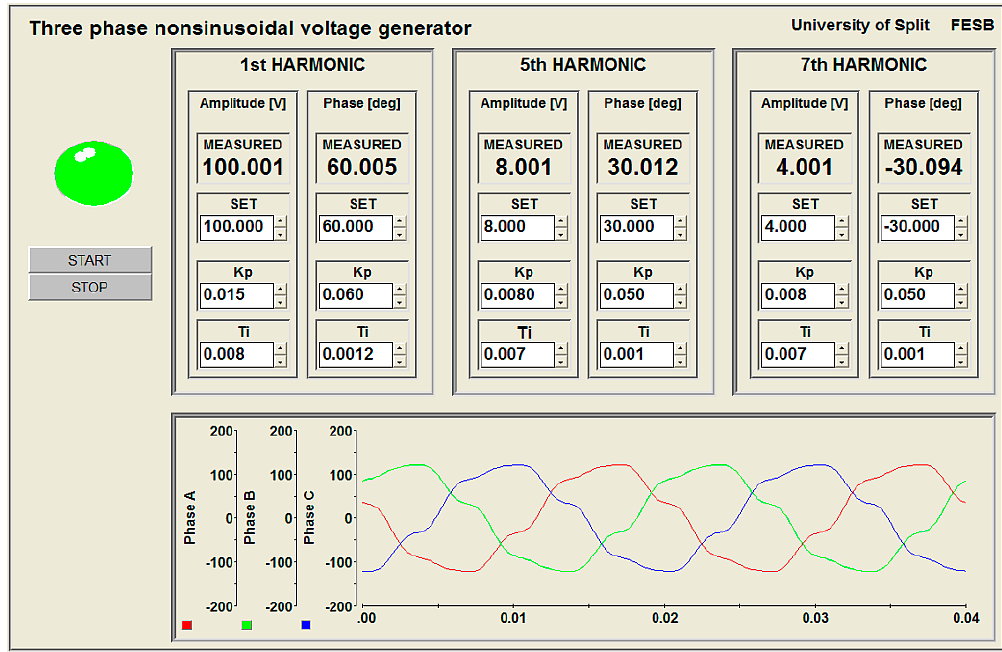
Figure 9. Graphical user interface (GUI) of three-phase non-sinusoidal voltage generator.